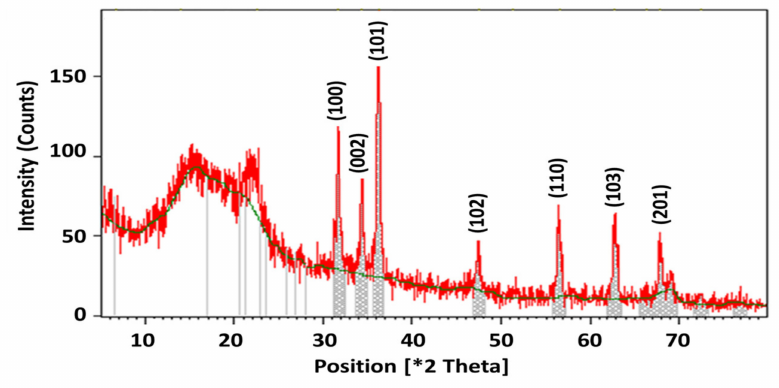
Figure 4. ZnPs XRD image.